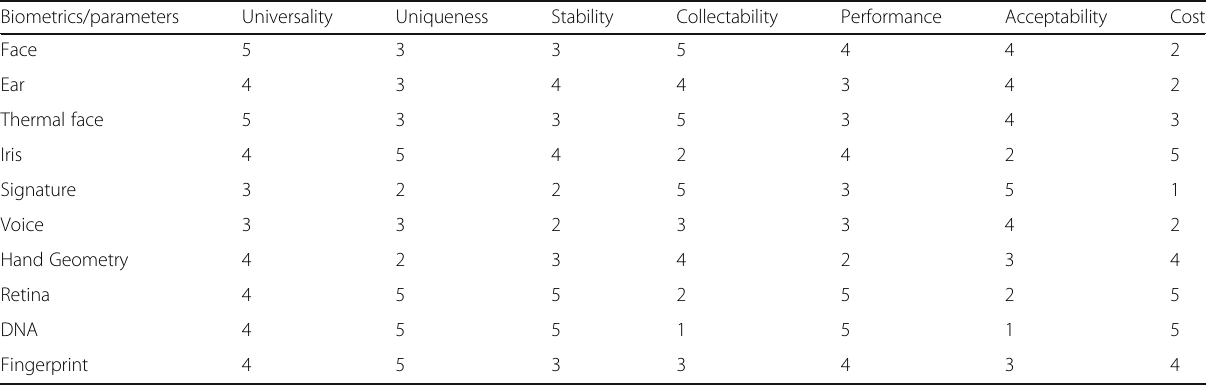
Table 1 Biometrics and parameters (5 high – 1 low)